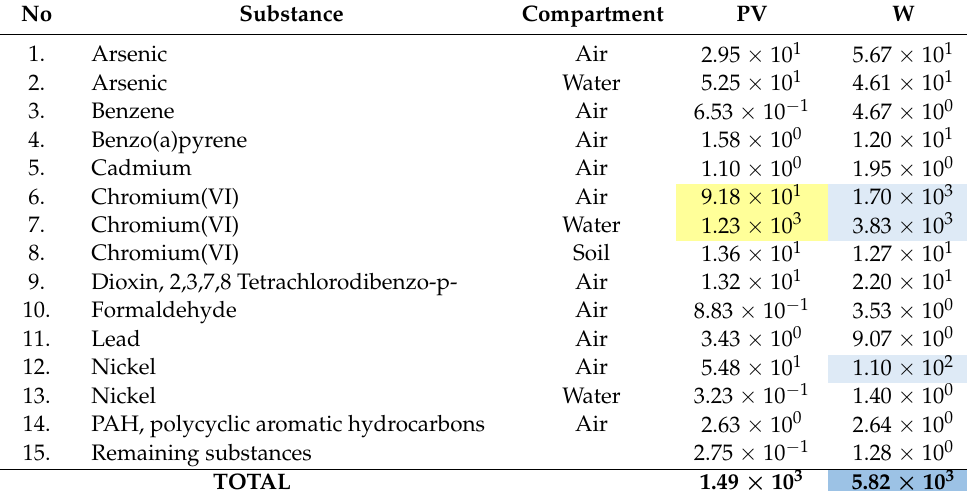
Table 5. Grouping and weighting results of environmental effects for human carcinogenic toxicity present in the life cycle of wind (W) and photovoltaic (PV) power plants (unit: Pt).